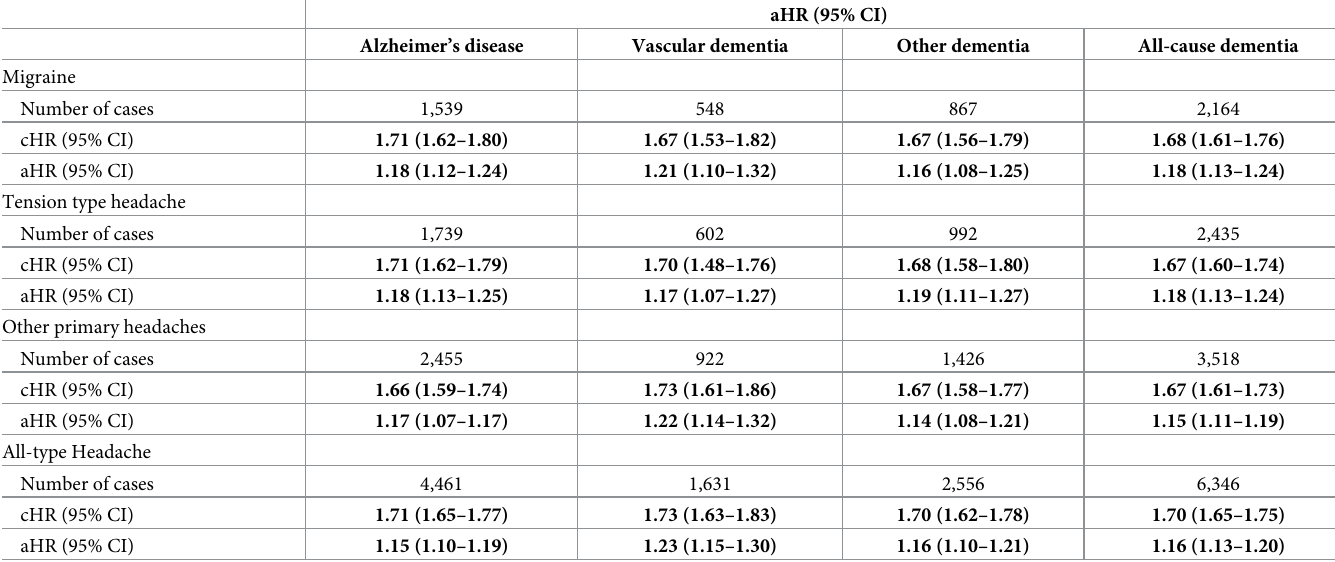
Table 2. Hazard ratios for dementias according to headache type.